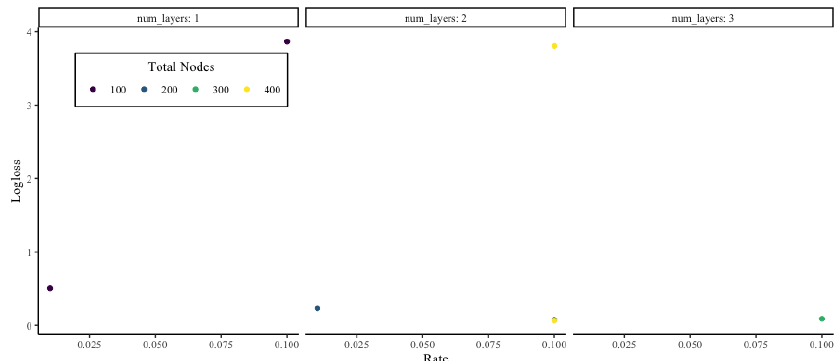
Figure 10. Visualization of the results from tuning deep learning models to predict claim frequency on the PD data. Here, we show the change in logloss across different values of learning rate for the deep neural network. The left pane shows the results when there is one layer, the middle pane shows results when there are two layers, and the right pane shows there are three layers. The coloring of the points correspond to the total number of nodes in the neural network.